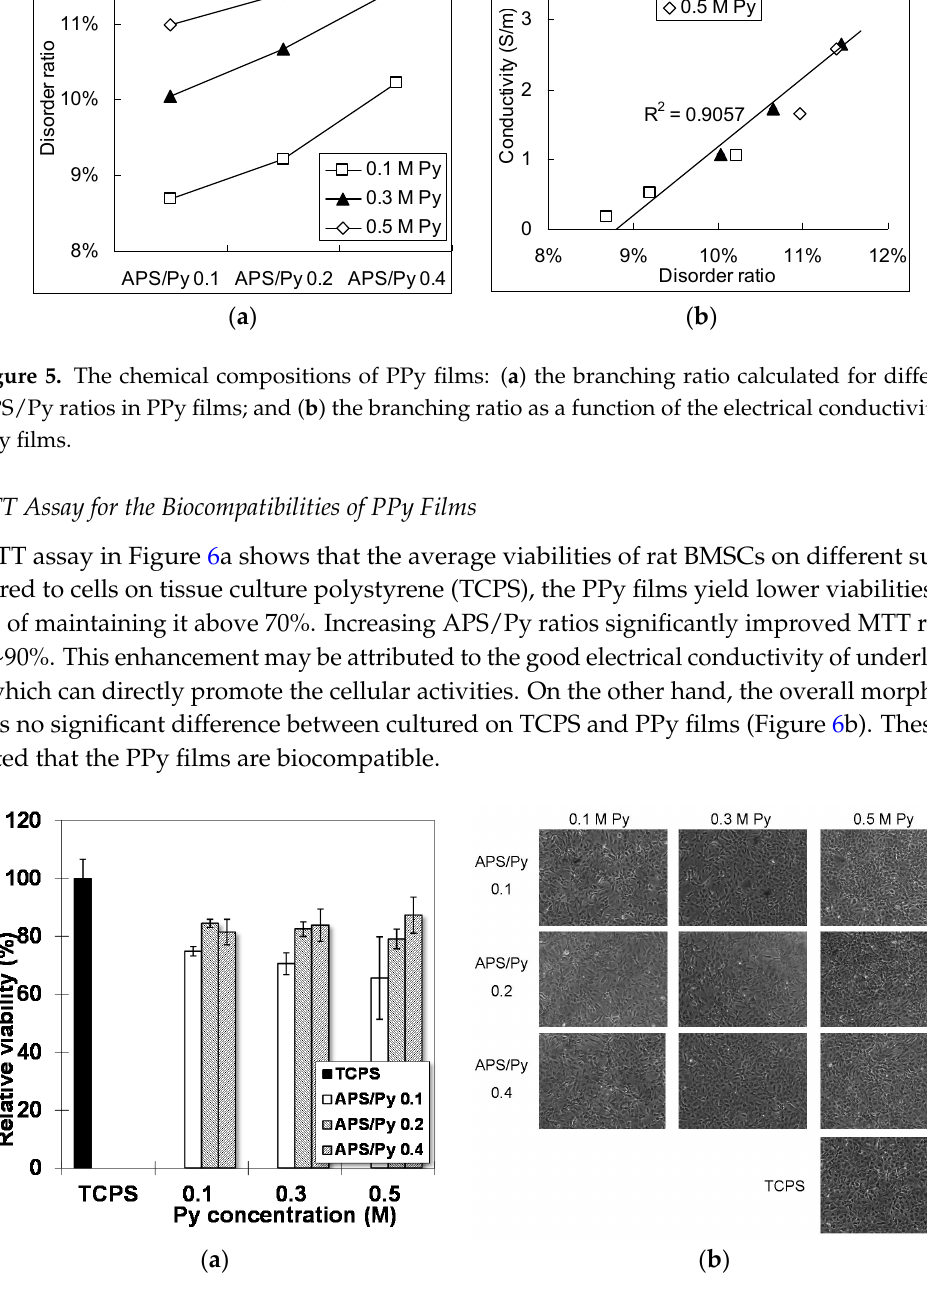
Figure 6. Biocompatibility of PPy films: ( a ) MTT assay; and ( b ) cell morphologies of BMSCs were observed one day after being seeded on PPy films (Scale bar = 100 μ m).